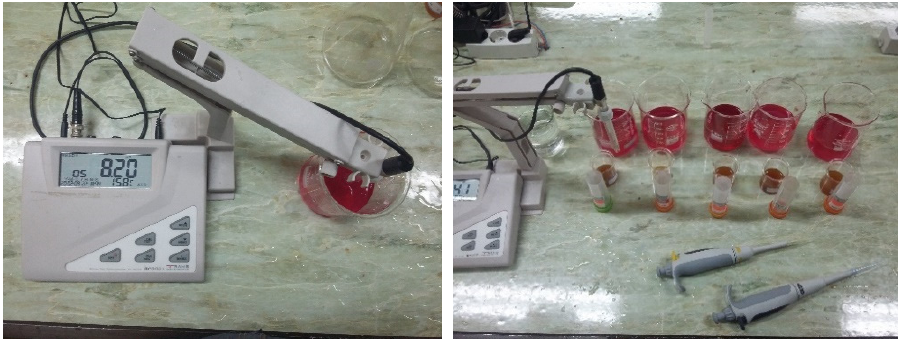
Figure 4. Method of titration.